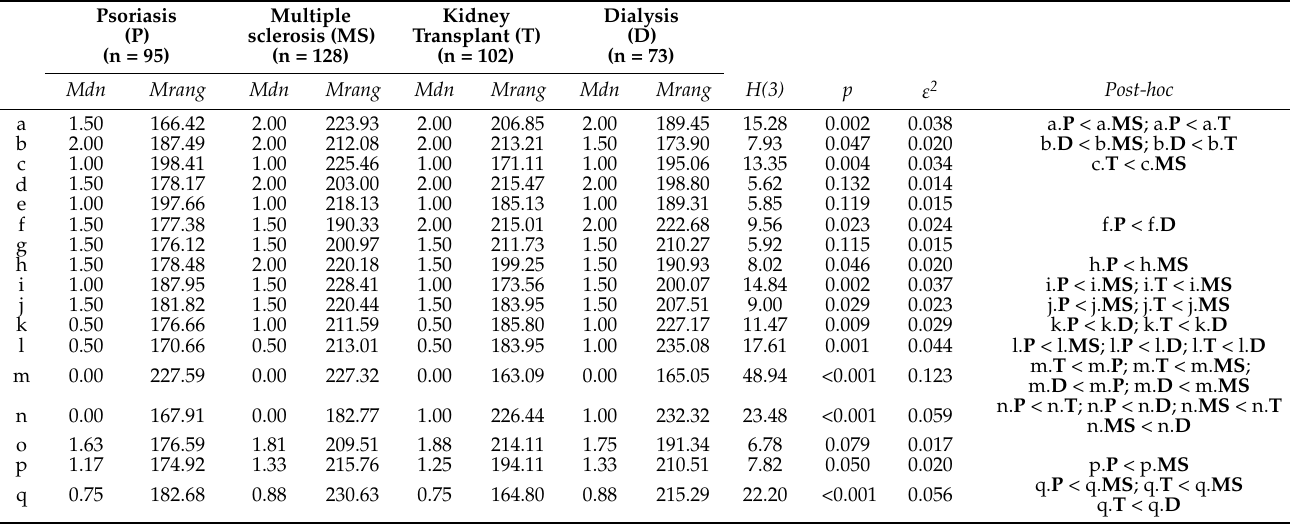
Table 3. Comparison of coping strategies between study